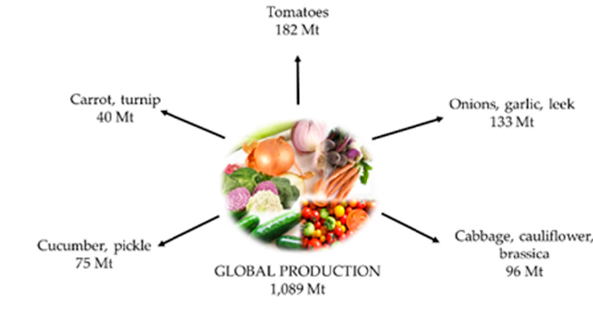
Figure 2. Global production of fruits and vegetables.